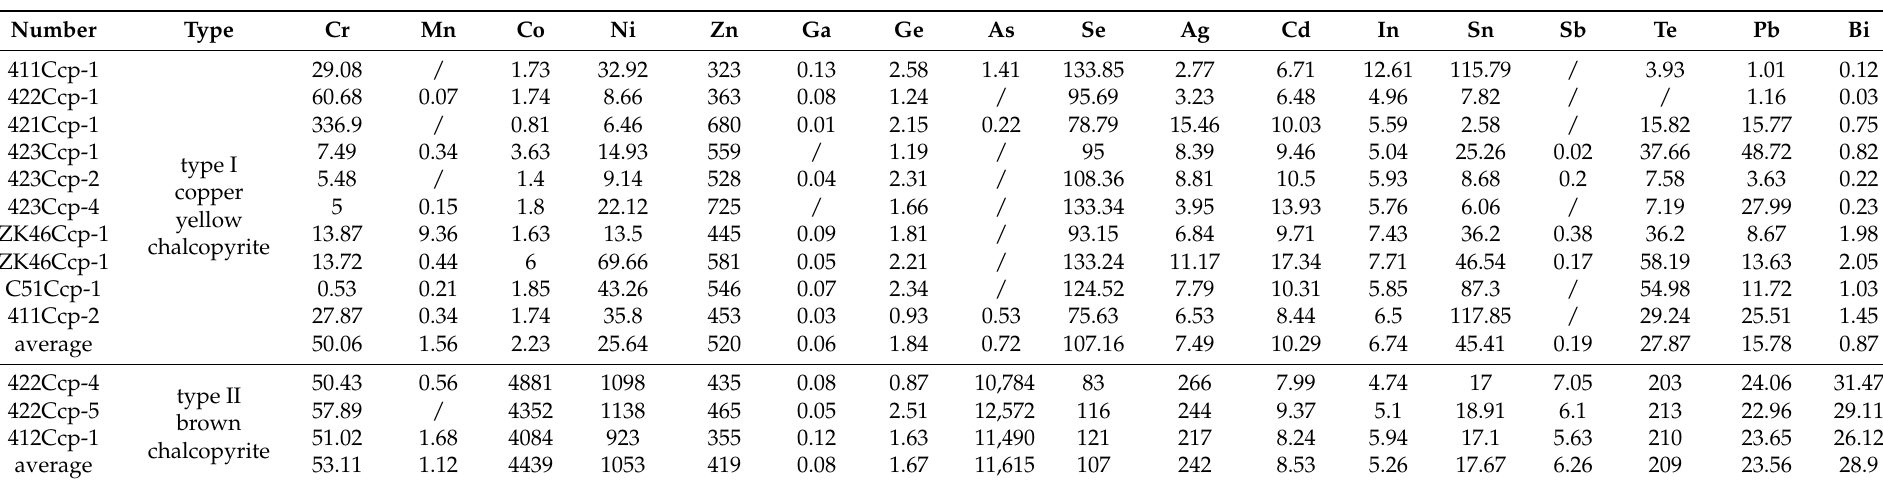
Table 3. Trace element analysis results of chalcopyrite in Huangyangshan deposit